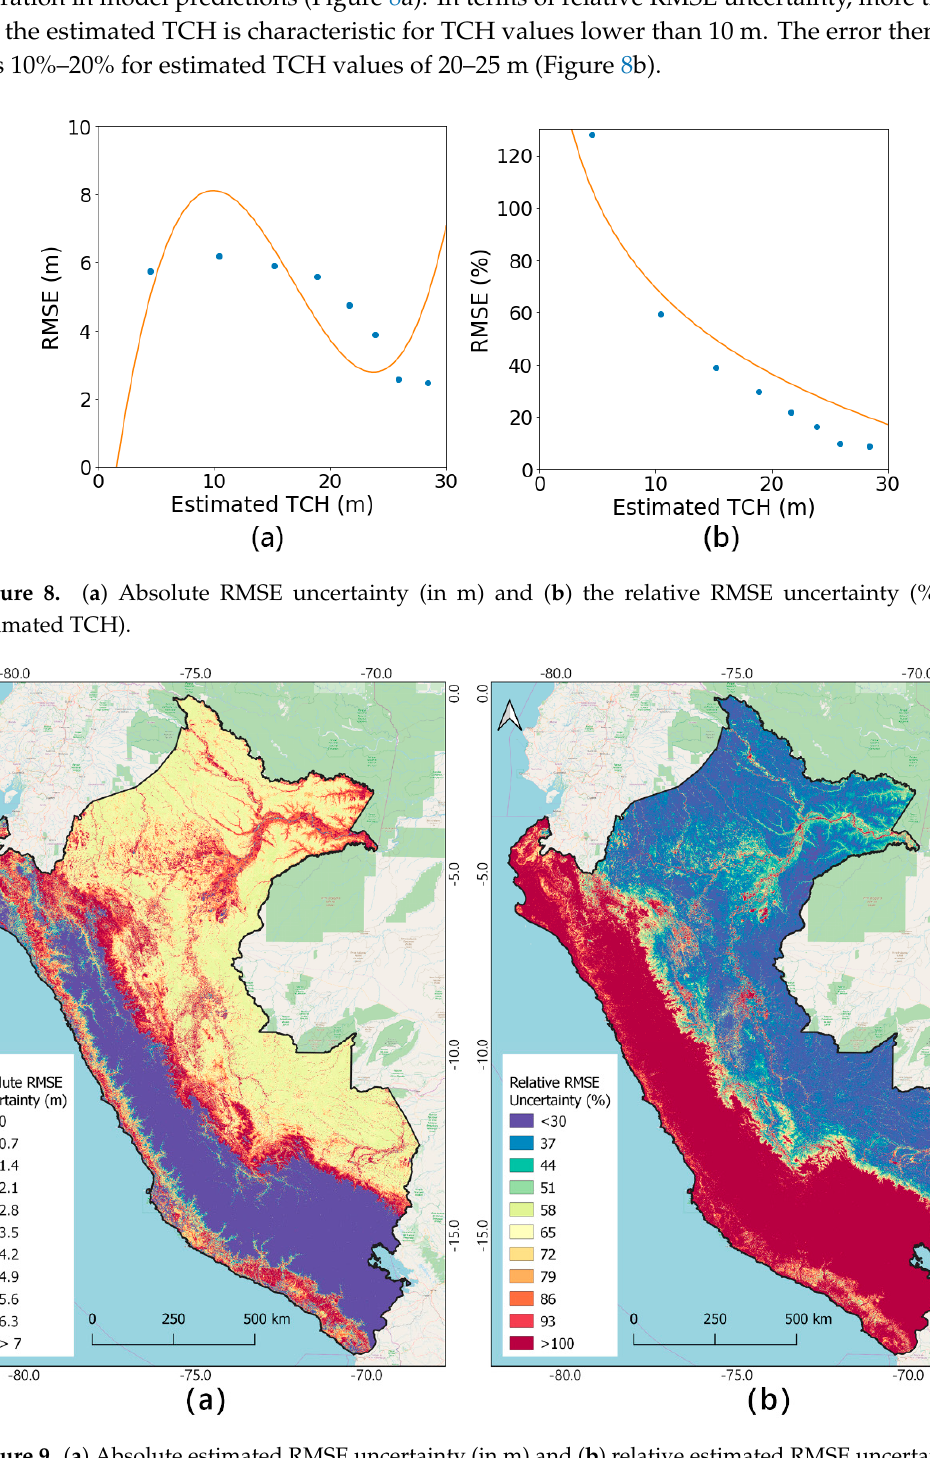
Figure 9. ( a ) Absolute estimated RMSE uncertainty (in m) and ( b ) relative estimated RMSE uncertainty (in % of estimated TCH) for all of